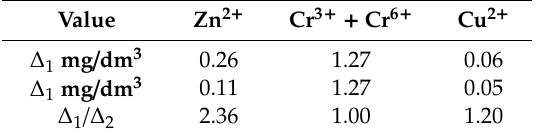
Table 8. Comparison of purification results with changing the scheme of fluid flow implementation.